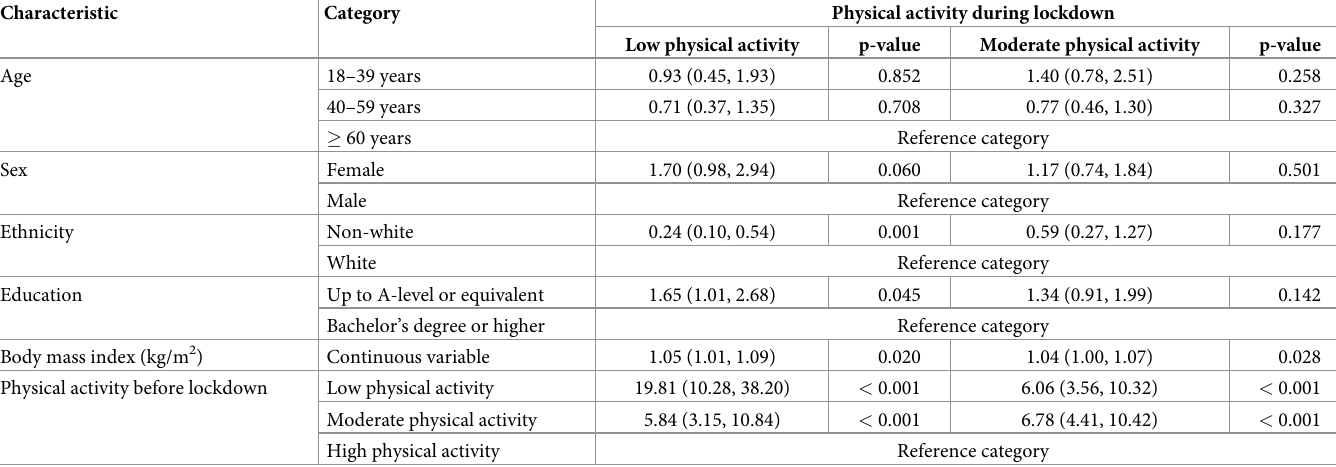
Table 3. Associations of demographic factors and pre-lockdown physical activity with physical activity during lockdown (reference category = high physical activity; n = 711). Characteristic